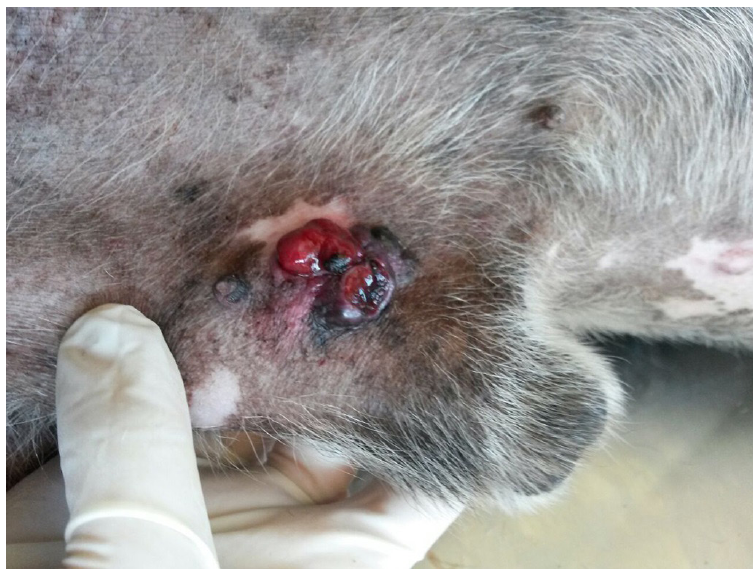
Figura 1. Canino, macho, formação nodular irregular de 2,5 cm × 2,0 cm, consistência firme elástica, coloração vermelho escuro, aderido, superfície rugosa e ulcerado, localizado caudalmente na face lateral direita do prepúcio. Tabela 1. Valores do hemograma de um cão macho, sem raça definida, 8 anos, com hemangiossarcoma